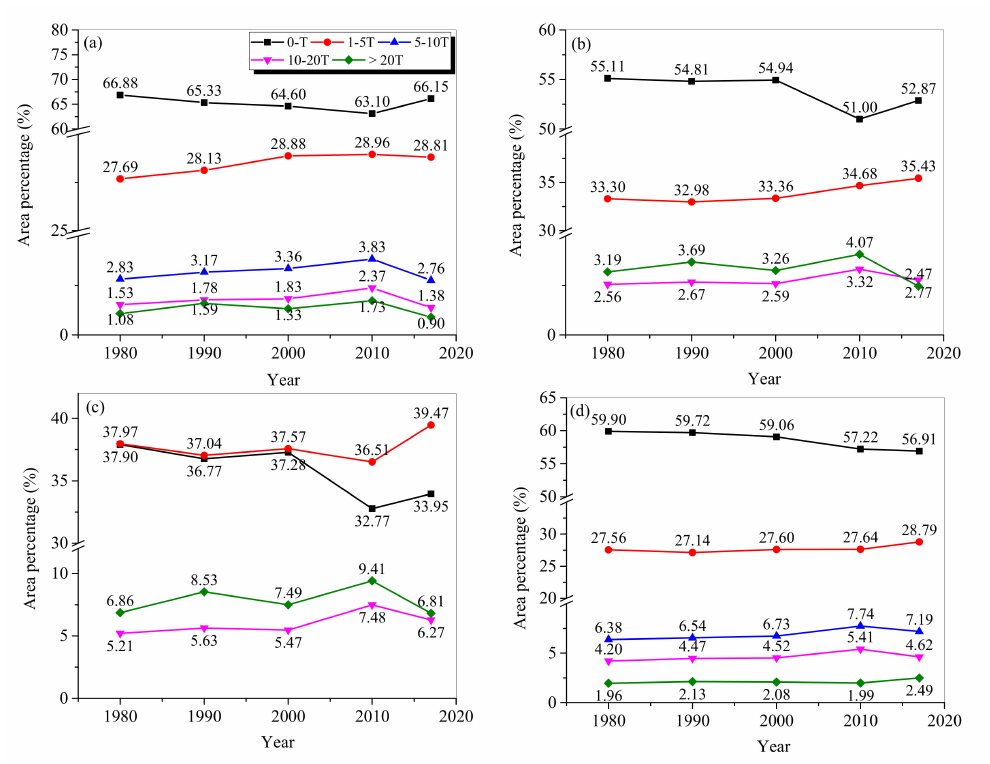
Figure 7. Area percentages of di ff erent erosion classes in Heilongjiang Province ( a ), Jilin Province ( b ), Liaoning Province ( c ), and ( d ) the IMA.